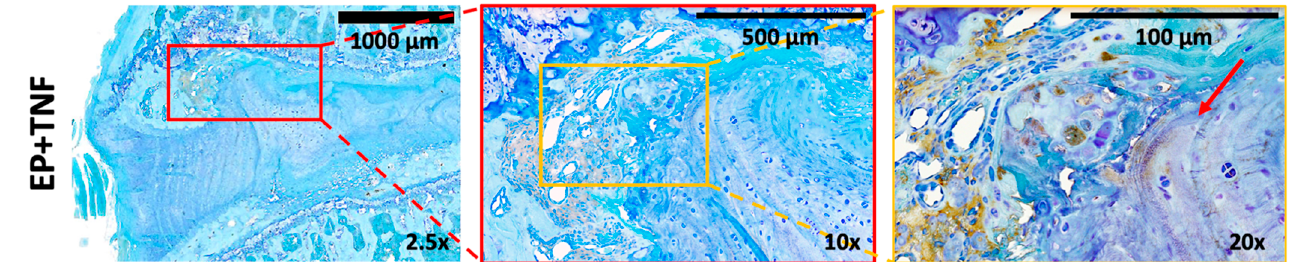
Figure 8. EP injury increased CD68-ir in vertebral and cartilage EP cells at the injury site. Repre- sentative EP+ TNF α images of CD68 immunohistochemical staining with toluidine blue showing disrupted EP structure with intense CD68-ir in the vertebral and cartilage EP regions in the injured EP in proximity to the injury site. There is also a lack of structural demarcation between cartilage and vertebral EP in proximity to the injury site. Red arrow indicates the injury site.